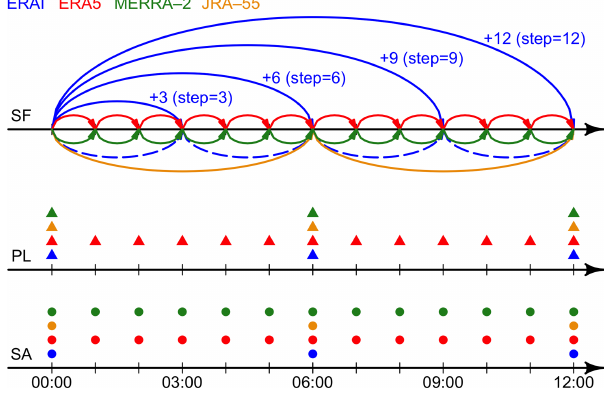
Figure 2. The representation of surface analysis (SA), surface fore- cast (SF) and pressure-level (PL) data in the four reanalyses sup- ported by GlobSim. The circles and triangles represent instanta- neous variables which are reported at specific temporal resolutions. The lines represent accumulated variables in the forecasts which are reported as the integral of a flux over the time interval spanned by each arrow. Because the surface forecasts in ERAI are accumulated from the beginning of the respective forecast cycle (the solid blue lines) rather than from the end of the previous step, they must be disaggregated (the dashed blue lines) using Eq. (2) to prevent over- lap in the integration